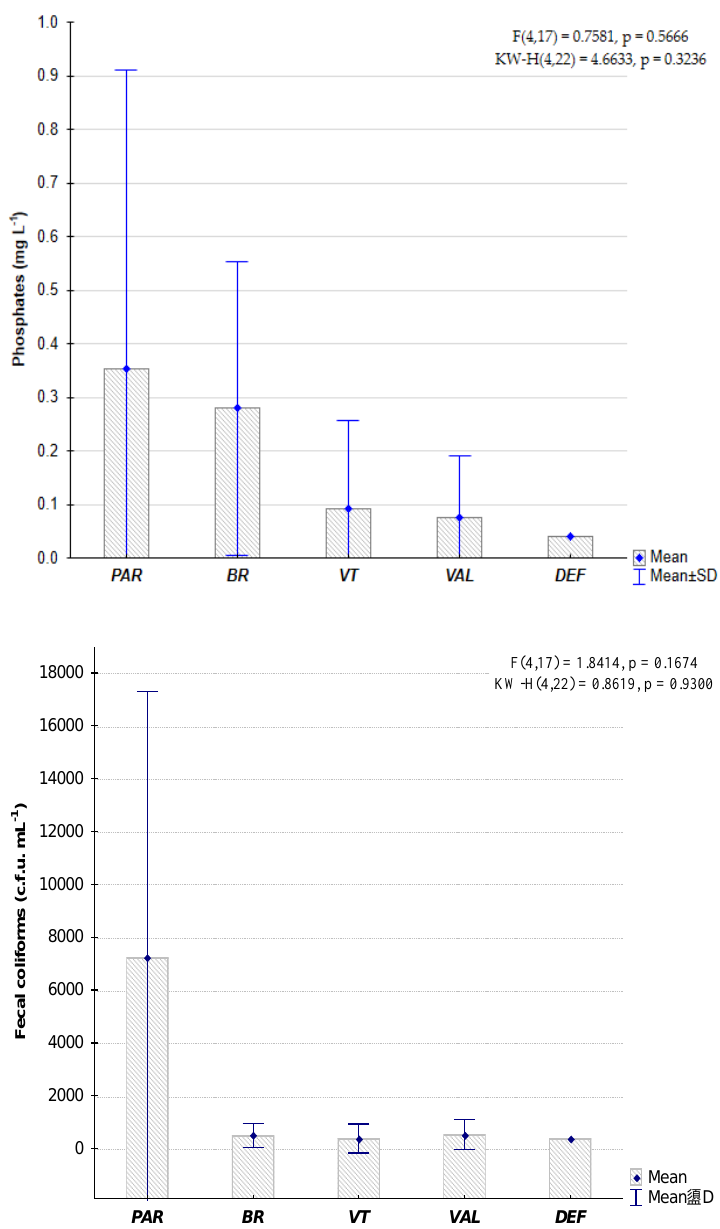
Figure 3. Mean values by farm of the concentrations of phosphates and fecal coliforms in water.